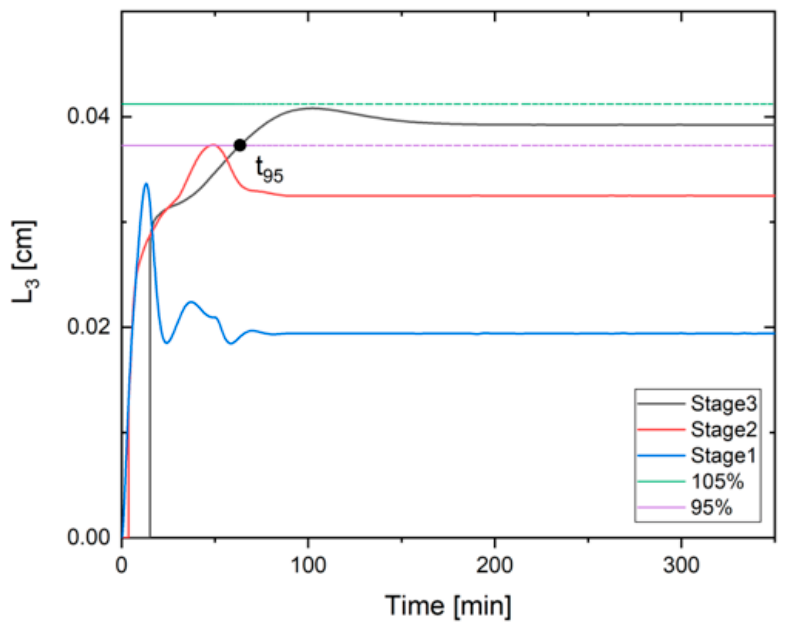
Figure 3. Dynamic profiles of the mean crystal size at different crystallization stages during